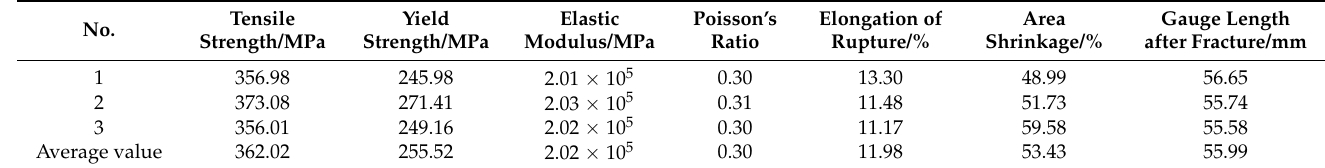
Table 5. Material behaviour test results.